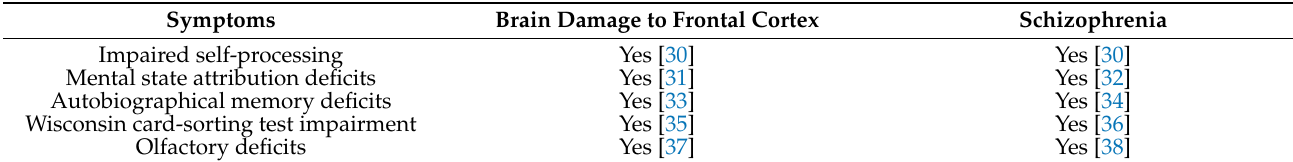
Table 3. Similarities between patients with frontal lobe damage and